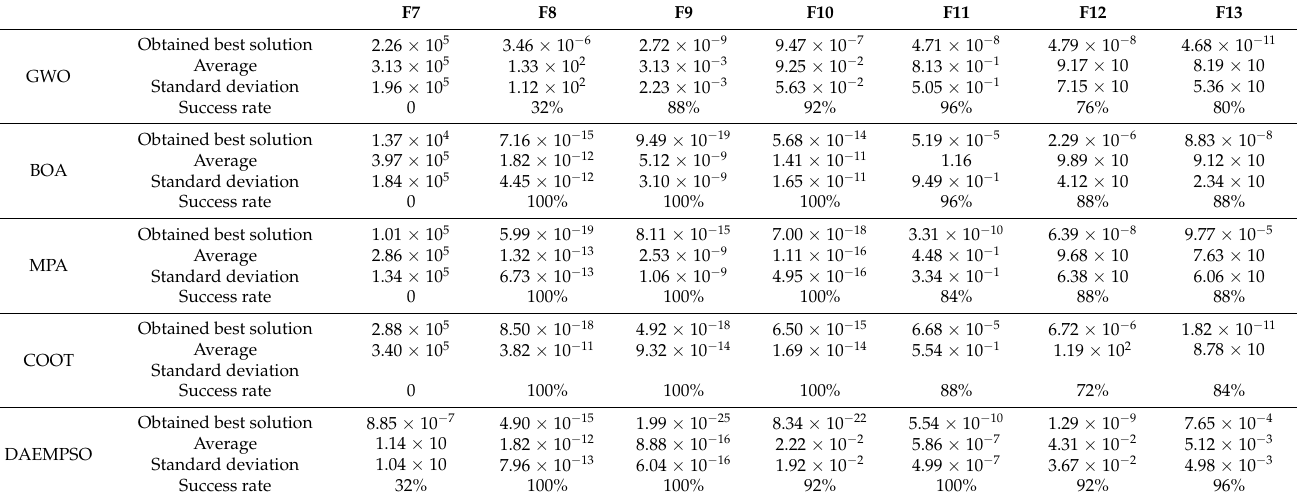
Table 8. Comparison of the optimization results of five algorithms for seven test functions (1000